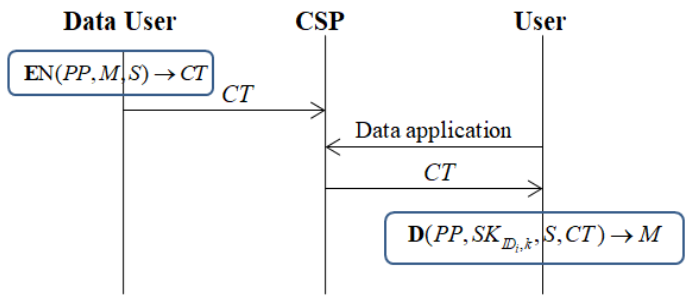
Figure 1. The encryption and decryption system of the scheme in [62].